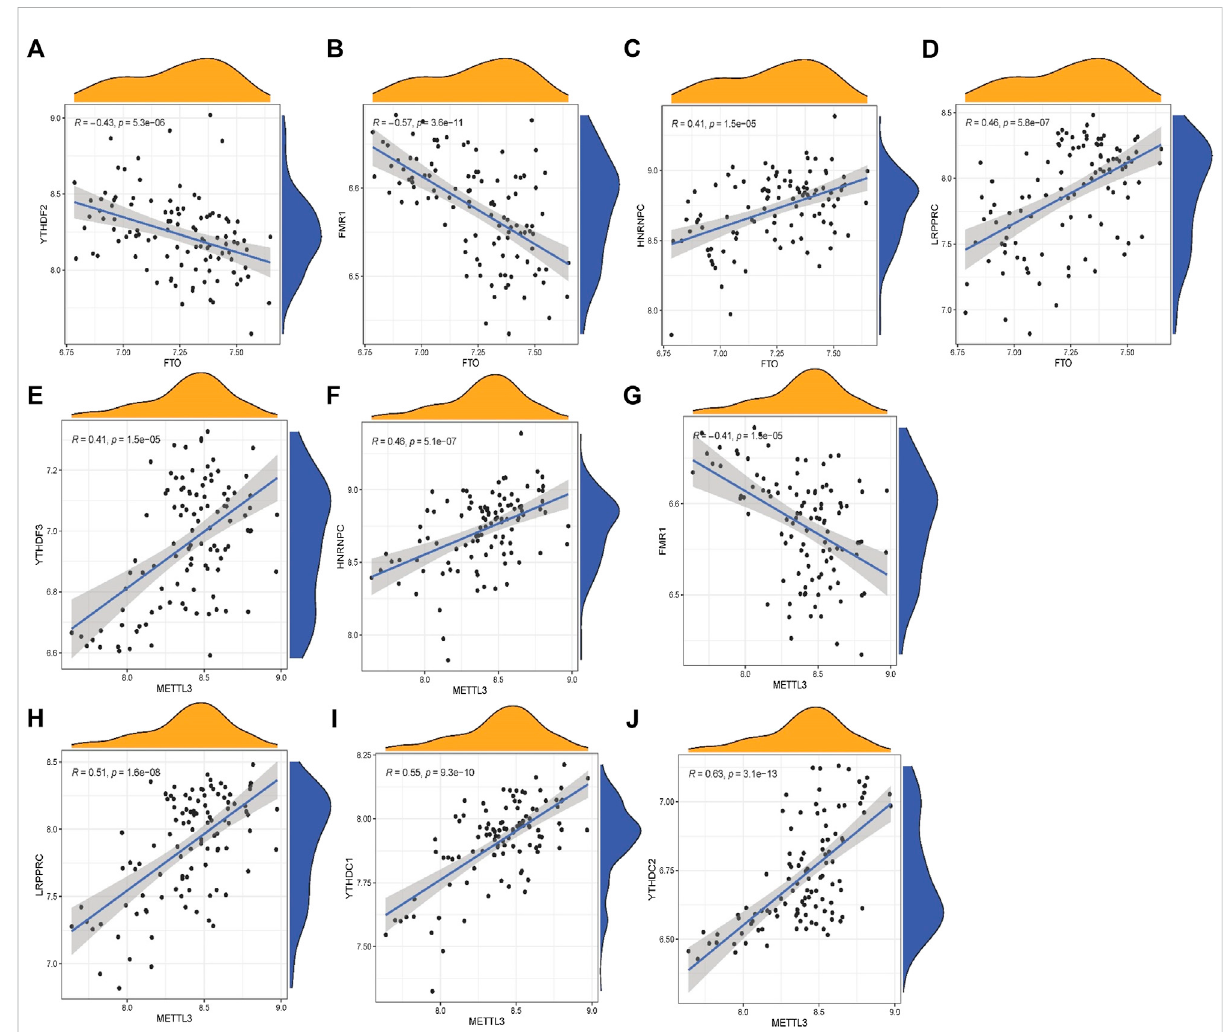
FIGURE 3 Correlation among writers, erasers, and readers in OA (A – J) . Reader genes: YTHDF2, FMR1, HNRNPC, LRPPRC, YTHDF3, YTHDC1, and YTHDC2; writer and eraser genes: METTL3 and FTO.